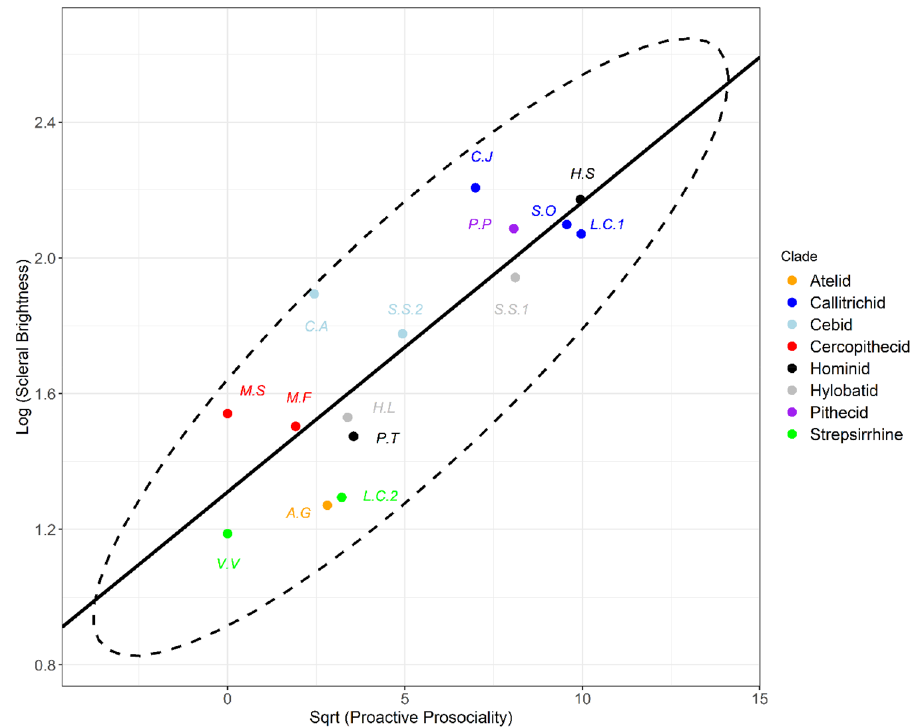
Figure 2. Proactive prosociality and scleral brightness. PGLS regression plot comparing log (proactive prosociality) with log (scleral brightness) in 15 primate species. Ellipse showing bivariate outliers to a 95% confidence interval. CJ Callithrix jacchus, HS Homo sapiens, SO Saguinus oedipus, LC1 Leontopithecus chrysomelas, PP Pithecia pithecia, SS1 Symphalangus syndactylus, SS2 Saimiri sciureus, CA Cebus